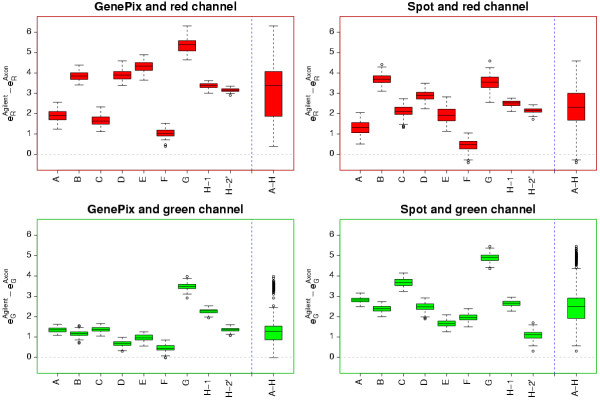
Comparison of bias estimates between scanners. Differences in the common biases ec between the Agilent and the Axon scanners for each separate array and for all arrays together. The bias is significantly larger for Agilent, regardless of channel (top and bottom) and image analysis method (left and right).